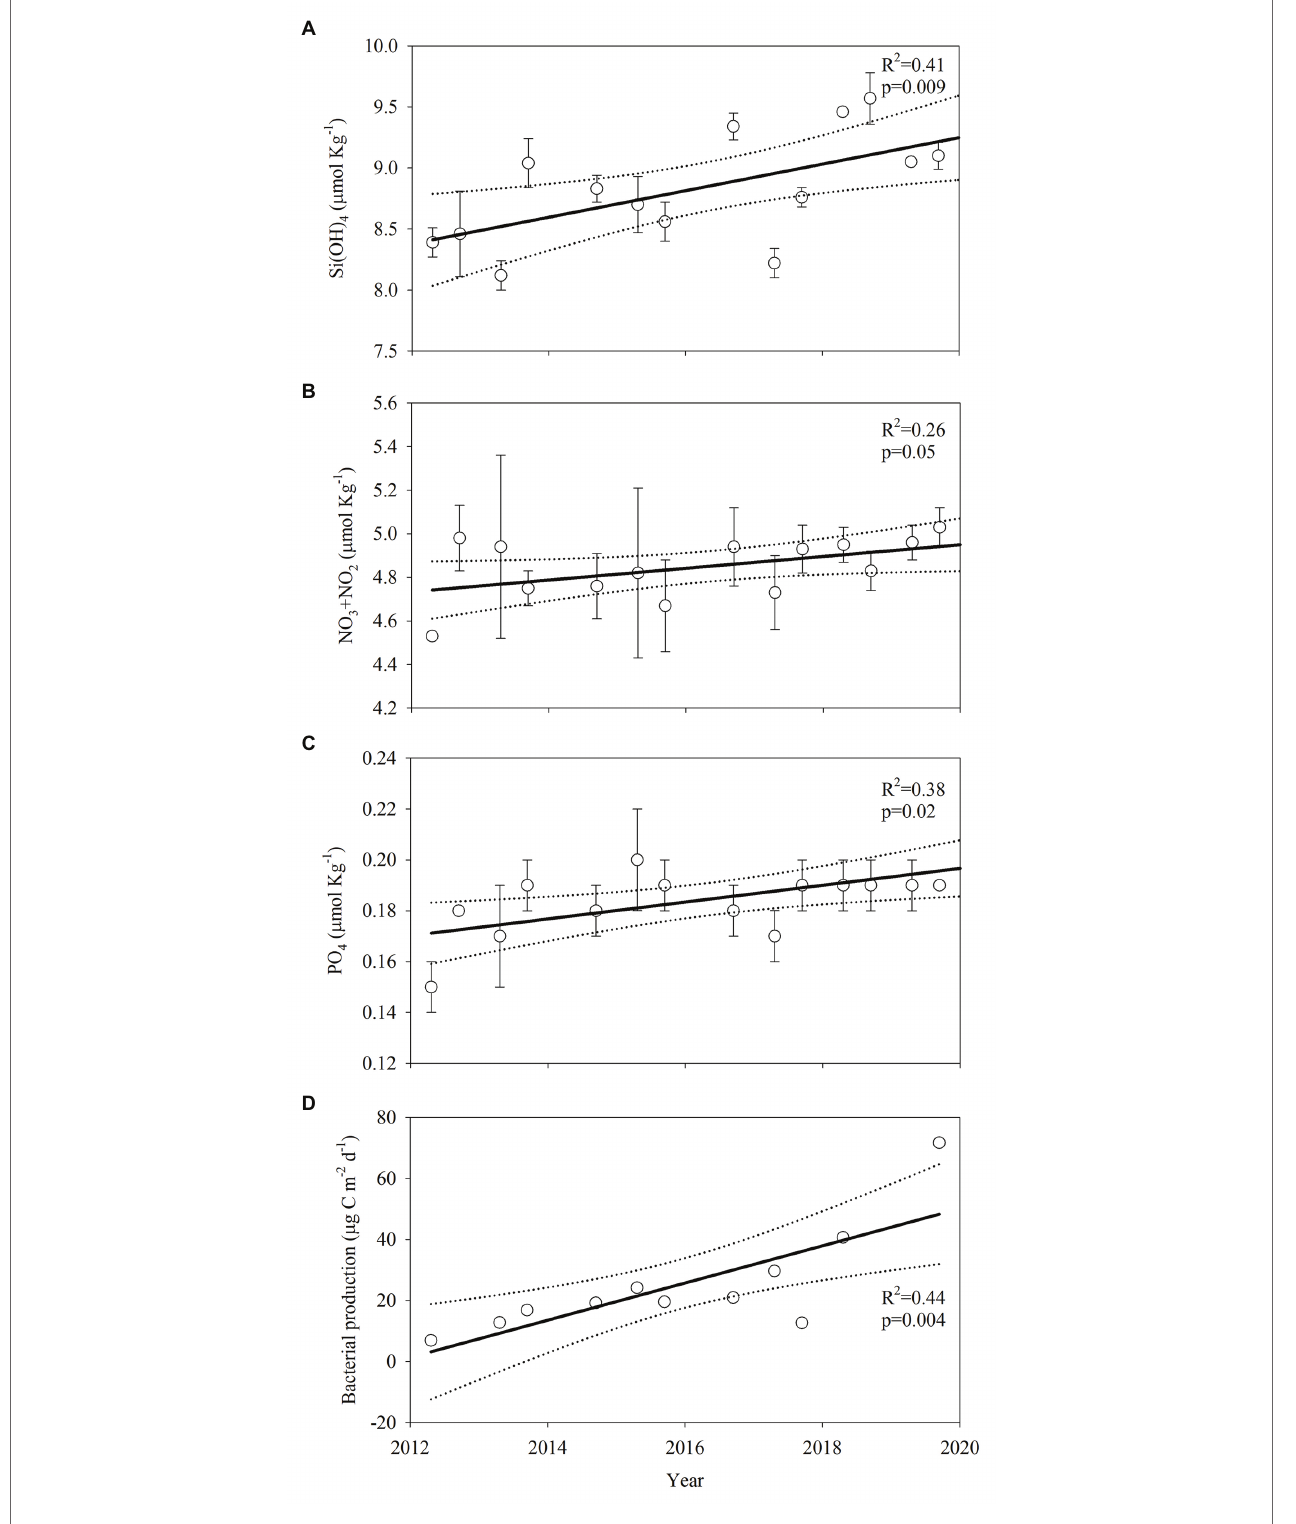
FIGURE 4 | Long term trends of mean Si(OH) 4 (A) , NO 3 + NO 2 (B) , and PO 4 (C) at depths of 1,200–1750 m during 2013–2020, and the integrated bacterial production (D) . The solid line shows the regression trend-line while the dotted lines show the 95% CI. R 2 and p denote the correlation coefficient and the corresponding